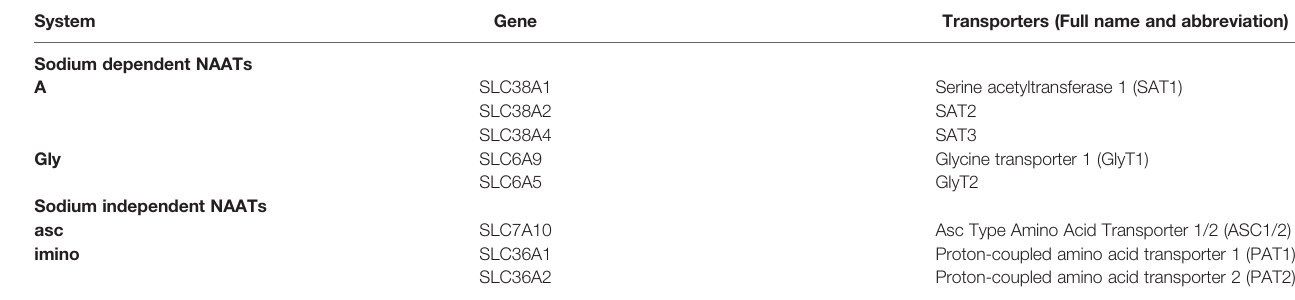
TABLE 1 | Neutral-amino-acid transporters which transport glycine. System